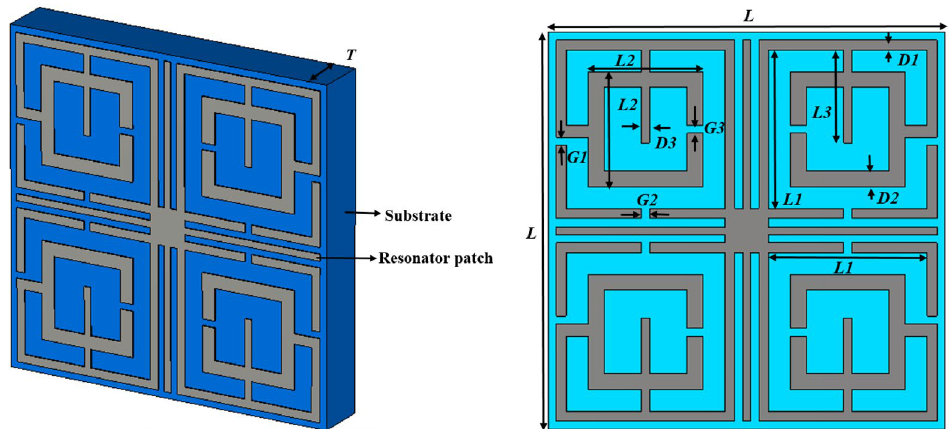
Figure 1. ( a ) Proposed MTM unit cell. ( b ) Structural layout of the patch of the proposed unit cell (CST STUDIO SUITE 2019, https:// www. 3ds. com/ produ cts- servi ces/ simul ia/ produ cts/ cst- studio- suite) 42 .